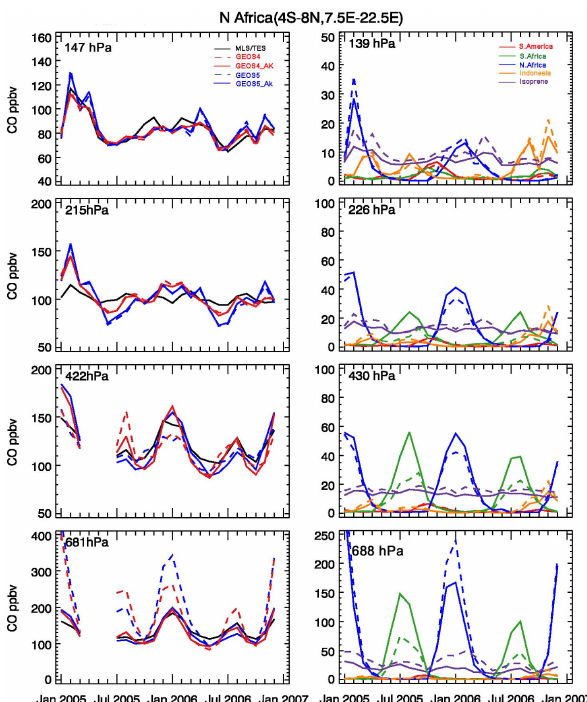
Fig. 21. Left: Time series of TES CO (681 and 422hPa) and MLS CO (215 and 147hPa, scaled as in Fig. 8) in (black) and model results for GEOS-4 (red) and GEOS-5 (blue) over northern Africa. Solid lines show the model results with the AKs applied, dashed lines show the model results without the AKs. Right: Time series of tagged CO tracers over northern Africa from individual sources: biomass burning in South America (red), southern Africa (green), northern Africa (blue) and Indonesia (orange), and the bio- genic source from isoprene (purple).